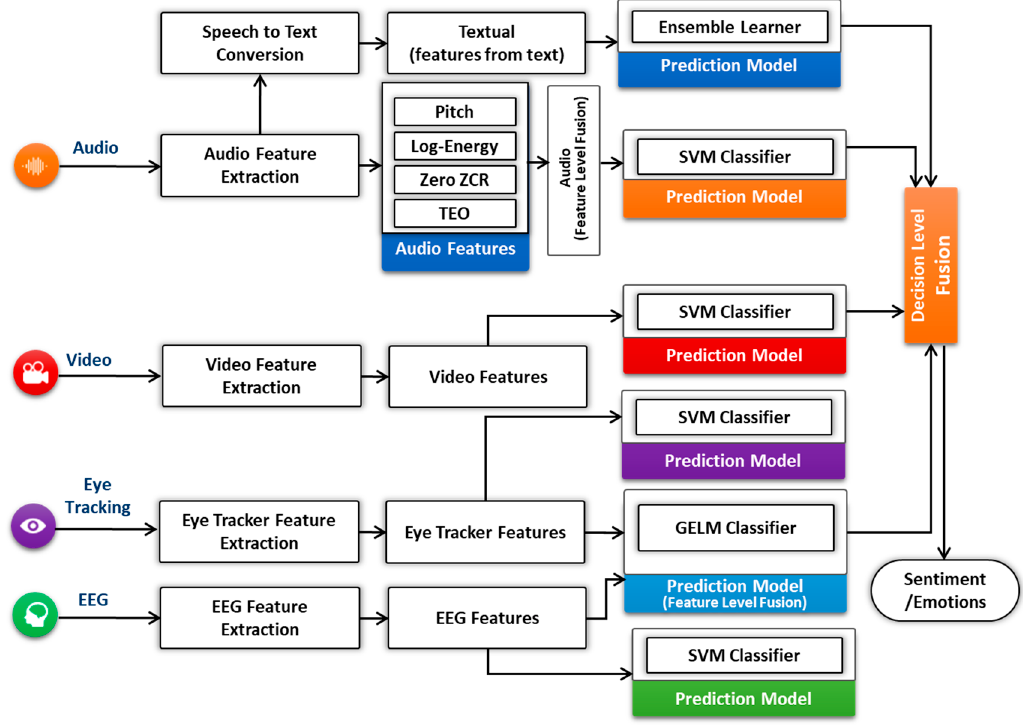
Figure 5. Hybrid level fusion for affect computing.